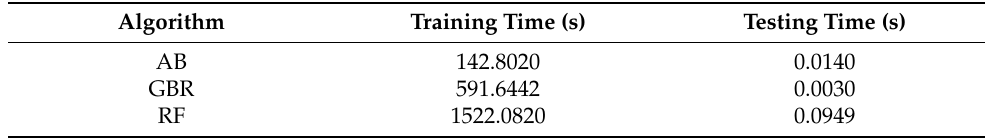
Table 9. Time complexity analysis of the algorithms.